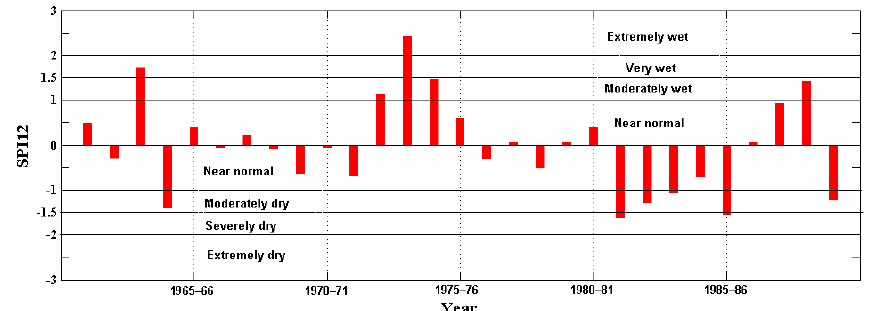
Figure 12. Historical time series of the SPI for a long-term scale. Table 5. Annual changes in T max in the future under the four GCMs and two scenarios (RCP4.5 and RCP8.5). Periods Annual change in T max ( ◦ C) CF method QM method RCP